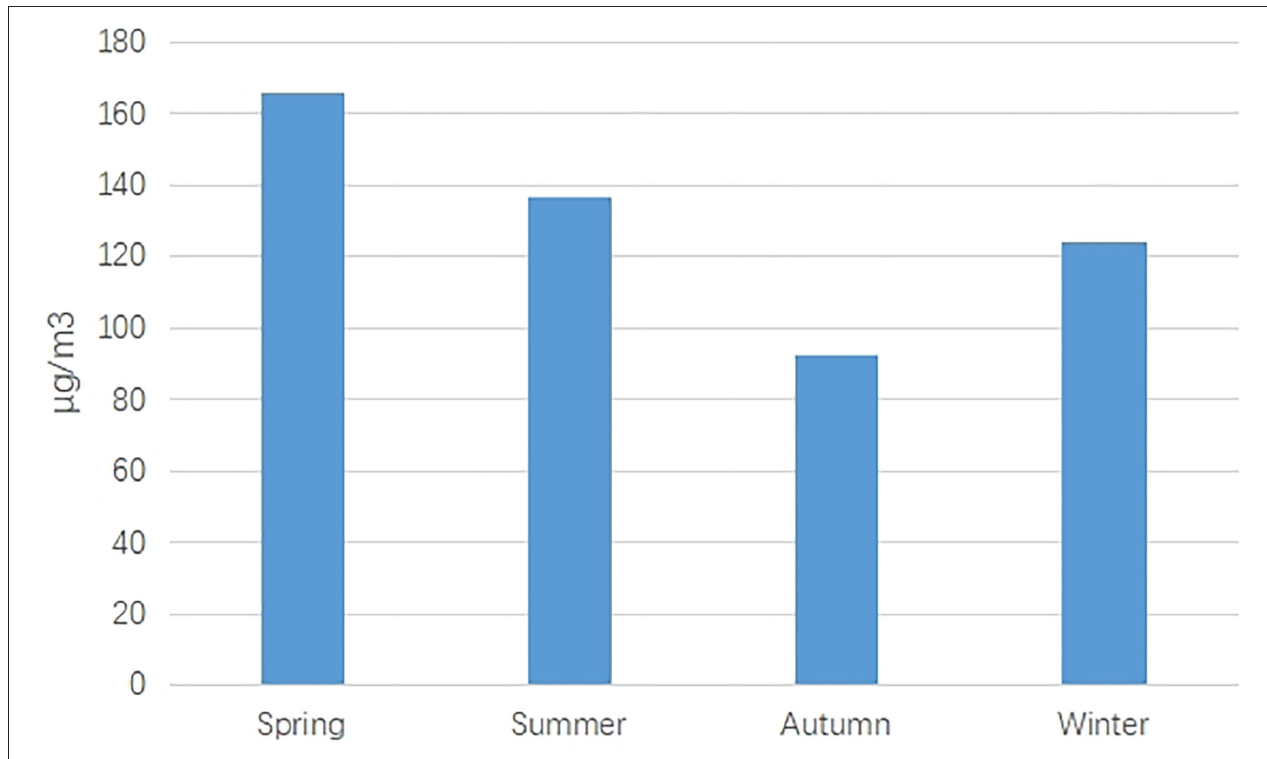
FIGURE 5 | The number of PM10 in different